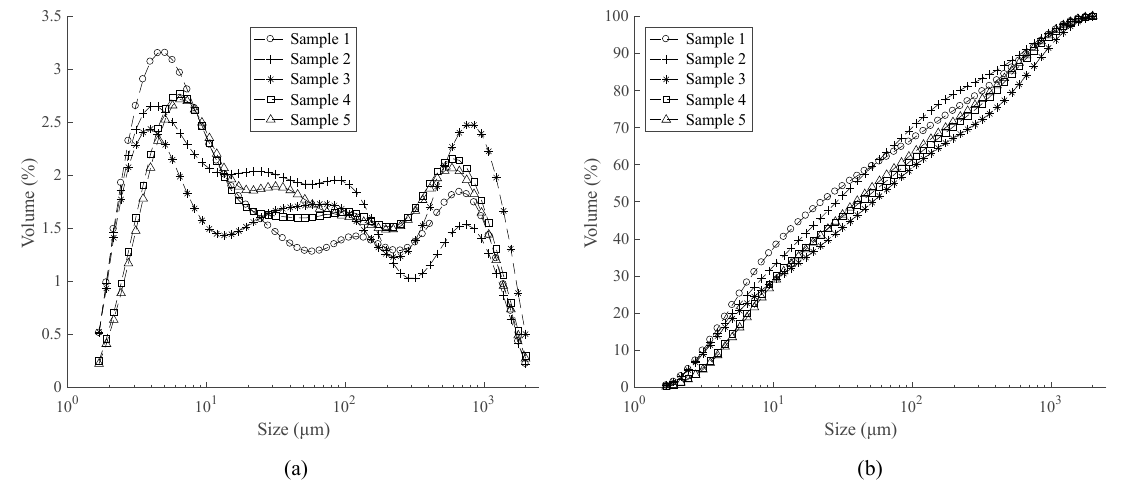
Figure 2. ( a ) Particle size distribution of 5 different samples from the collected concentrated domestic slurries (CDS) ( b ) Cumulative particle size distribution of the 5 samples.